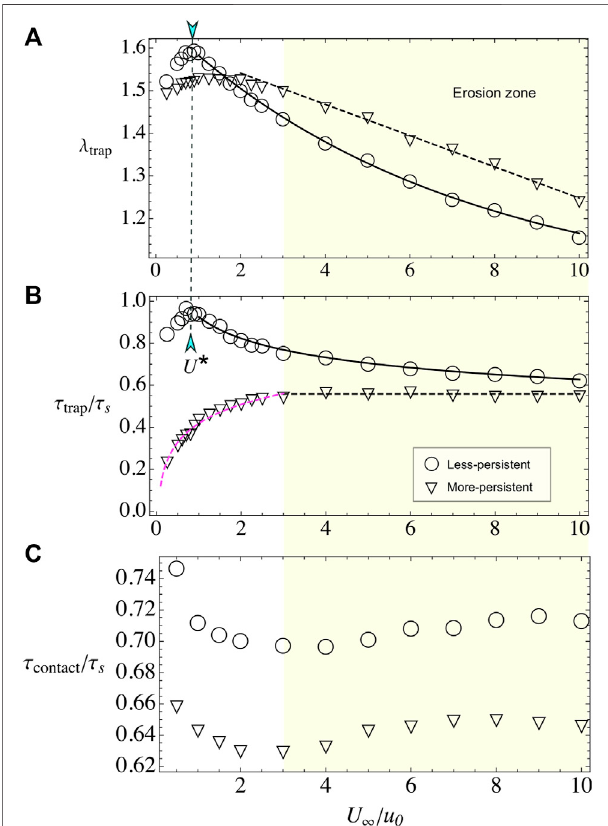
FIGURE 6 | Bacterial adhesion when varying external fl ow U ∞ . (A) λ trap for less- and more-persistent microswimmers. In both cases, the obstacle adheres an increasing number of microswimmers on the surface for weak fl ows, while for U ∞ > U * particles are rapidly eroded from the surface. (B) The time to reach the steady-state τ trap has different behaviors depending on themicroswimmer ’ spersistence. (C) Whenvaryingexternal fl ow, U ∞ ,keeping R =100 and u 0 =20 fi xed, the contact time fl uctuates around a constant value, with less-persistent microswimmers spending more time at the obstacle